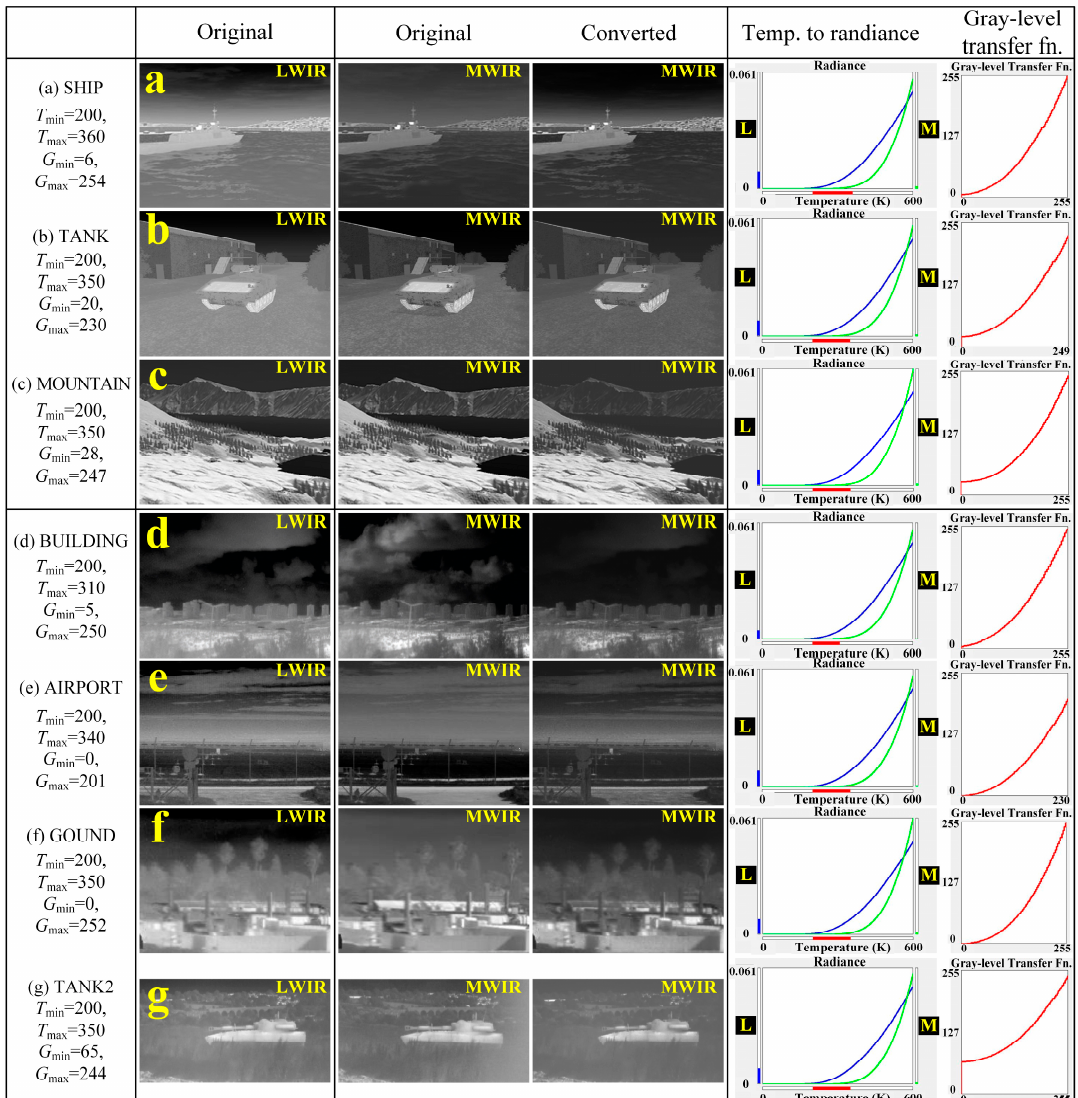
Figure 12. Comparison of converted MWIR image by proposed method and modeled MWIR images (( a ) SHIP, ( b ) TANK, and ( c ) MOUNTAIN) made by IR sensor simulator and actual MWIR images (( d ) BUILDING, ( e ) AIRPORT, ( f ) GROUND, and ( g ) TANK2).